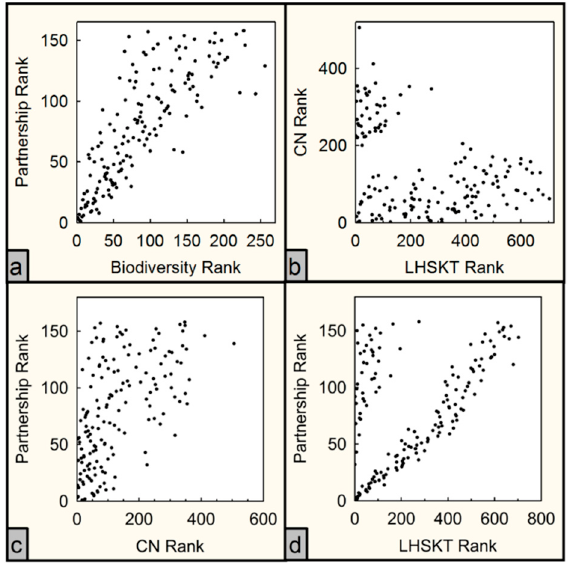
Figure 5. Depiction of how the conservation priority rank of a subset of sites (the “long-list”) compared between various outputs. Each dot represents a site. The comparisons are between ( a ) the partnership and biodiversity outputs (r s = 0.84); ( b ) CapeNature (CN) and Leslie Hill Succulent Karoo Trust (LHSKT) outputs (r s = − 0.24); ( c ) the partnership and CN outputs (r s = 0.61); and ( d ) the partnership and LHSKT outputs (r s = 0.39).